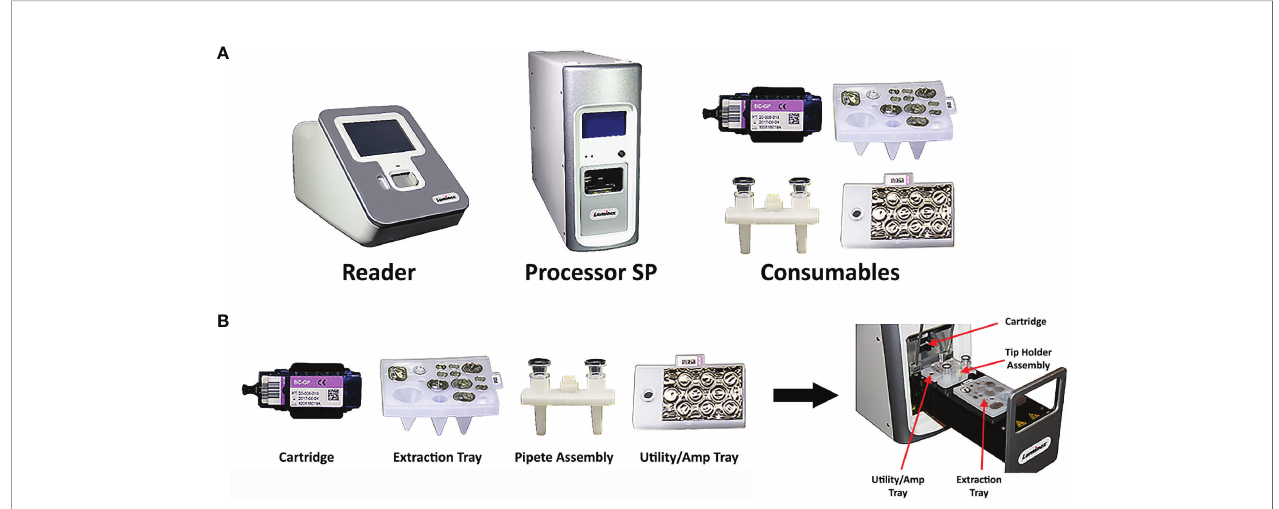
FIGURE 1 | Composition of the VERIGENE ® System. (A) The VERIGENE System includes the VERIGENE Reader, the Processor SP, and the consumables for the speci fi c assay. (B) The VERIGENE test consumables include the VERIGENE Test Cartridge, the extraction tray, the pipette assembly, and the utility/amp